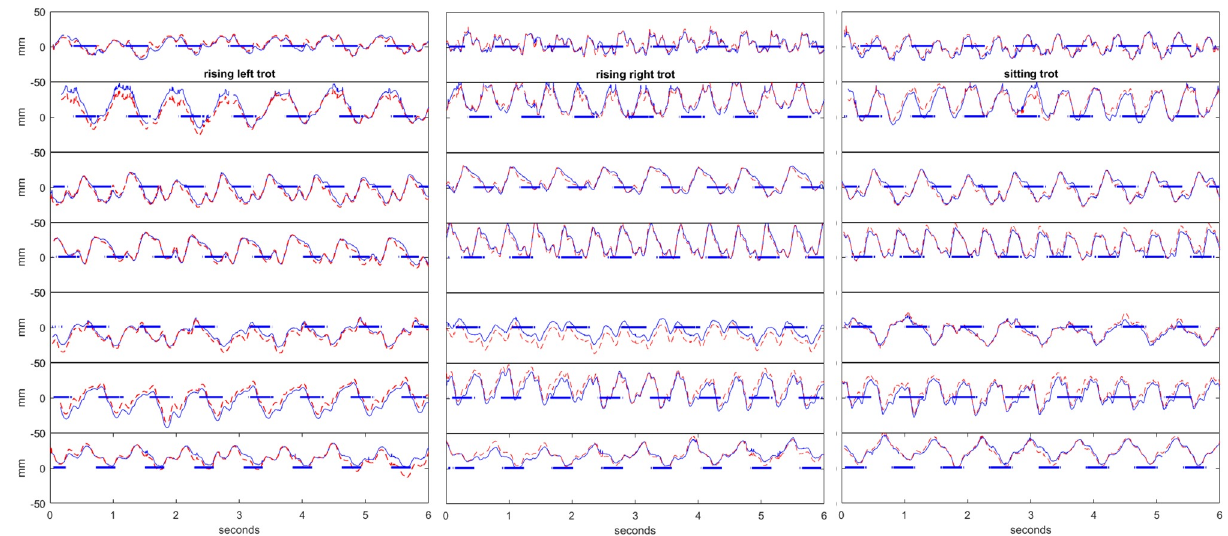
Fig 1. Lateral movement of the saddle. The blue line shows the lateral distance between the third lumbar vertebra and caudal part of the saddle perpendicular to the horse’s spine in all horses for left and right rising trot (rider rising on the left and right hind limb diagonal, respectively) and sitting trot. The dotted red line shows the same distance along the transverse axis of the laboratory coordinate system. Positive y-axis values indicate that the saddle is to the right of the vertebrae. The blue horizontal bars indicate right front/left hind limb diagonal supports.